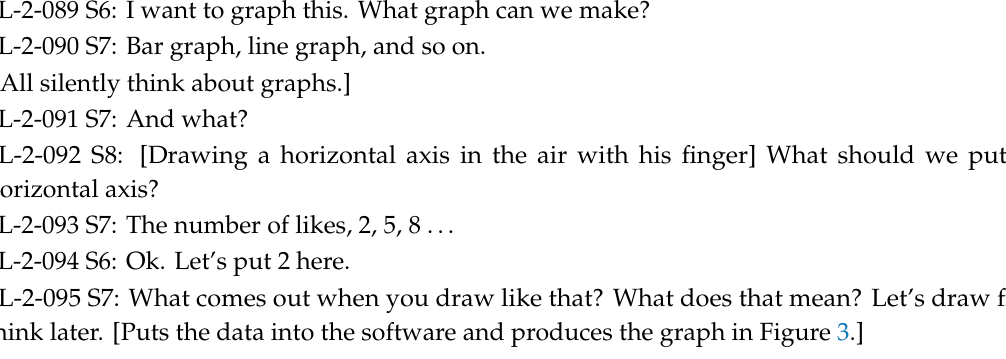
Figure 3. Frequency of number of likes.